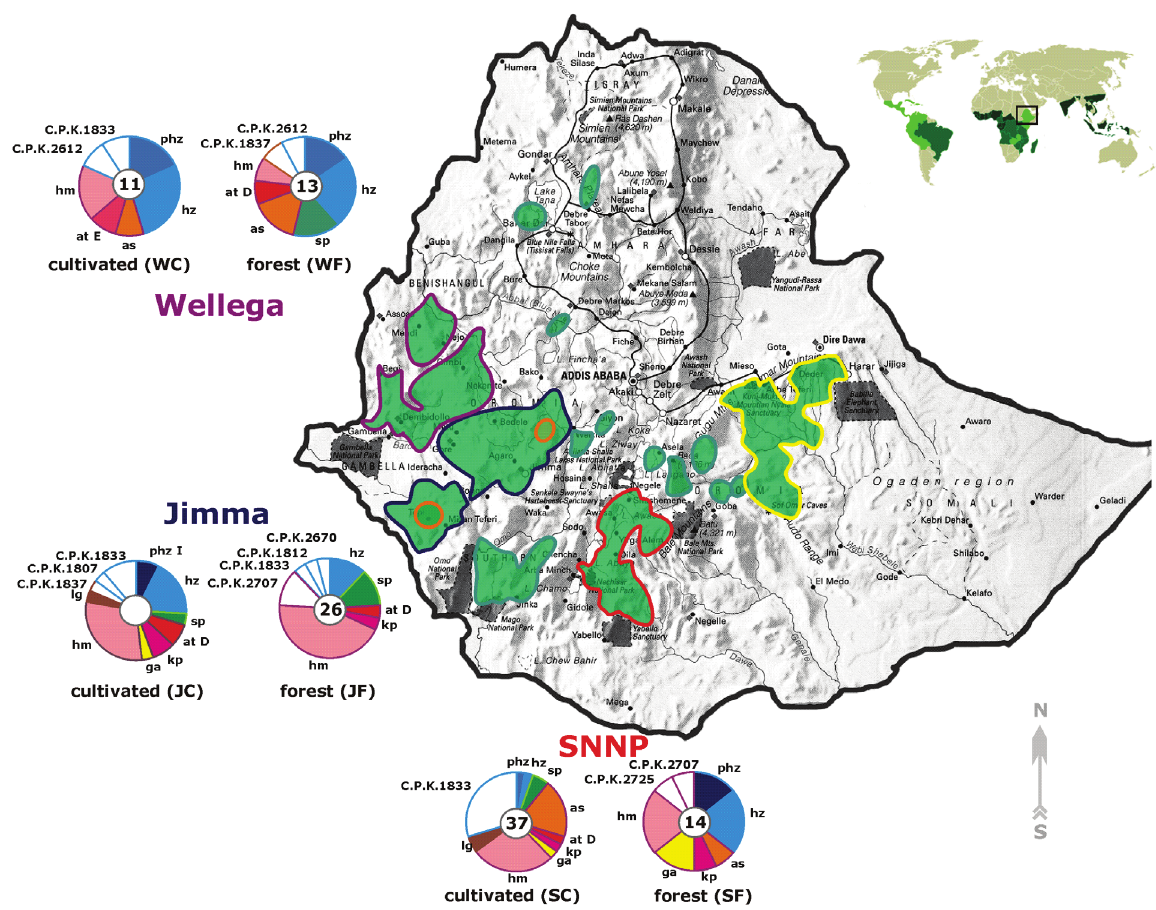
Figure 1. Location of the main coffee growing areas (green areas) and the corresponding diversity of Hypocrea/Trichoderma in the rhizosphere of C . arabica . The purple line corresponds to Wellega, blue to Jimma, red for the SNNP region and yellow for the Hararghe region. The orange circles indicate the main commercial coffee plantation sites in Ethiopia (Jimma). The diversity of Hypocrea/Trichoderma is shown by separate pie plots (disturbed semi-forest and native forest, respectively) for all coffee growing areas except Hararghe, which was undersampled. The number in the center of each plot indicates the total number of Trichoderma strains isolated from each area. Species are abbreviated as T . harzianum sensu stricto (hz), ‘pseudoharzianum matrix’ (phz), T . hamatum (hm), Hypocrea atroviridis clade E (at E), H . atroviridis clade D (at D), T . asperelloides (as), T . spirale (sp), T . longibrachiatum (lg), T . gamsii (ga), and H . koningiopsis (kp), all potentially new species are numbered as “ T . sp.” followed by the corresponding strain number. The world map inset on the upper right side of the image shows the location of Ethiopia in the “coffee belt” where the light green indicates C . arabica production areas, and the dark green shows C . robusta